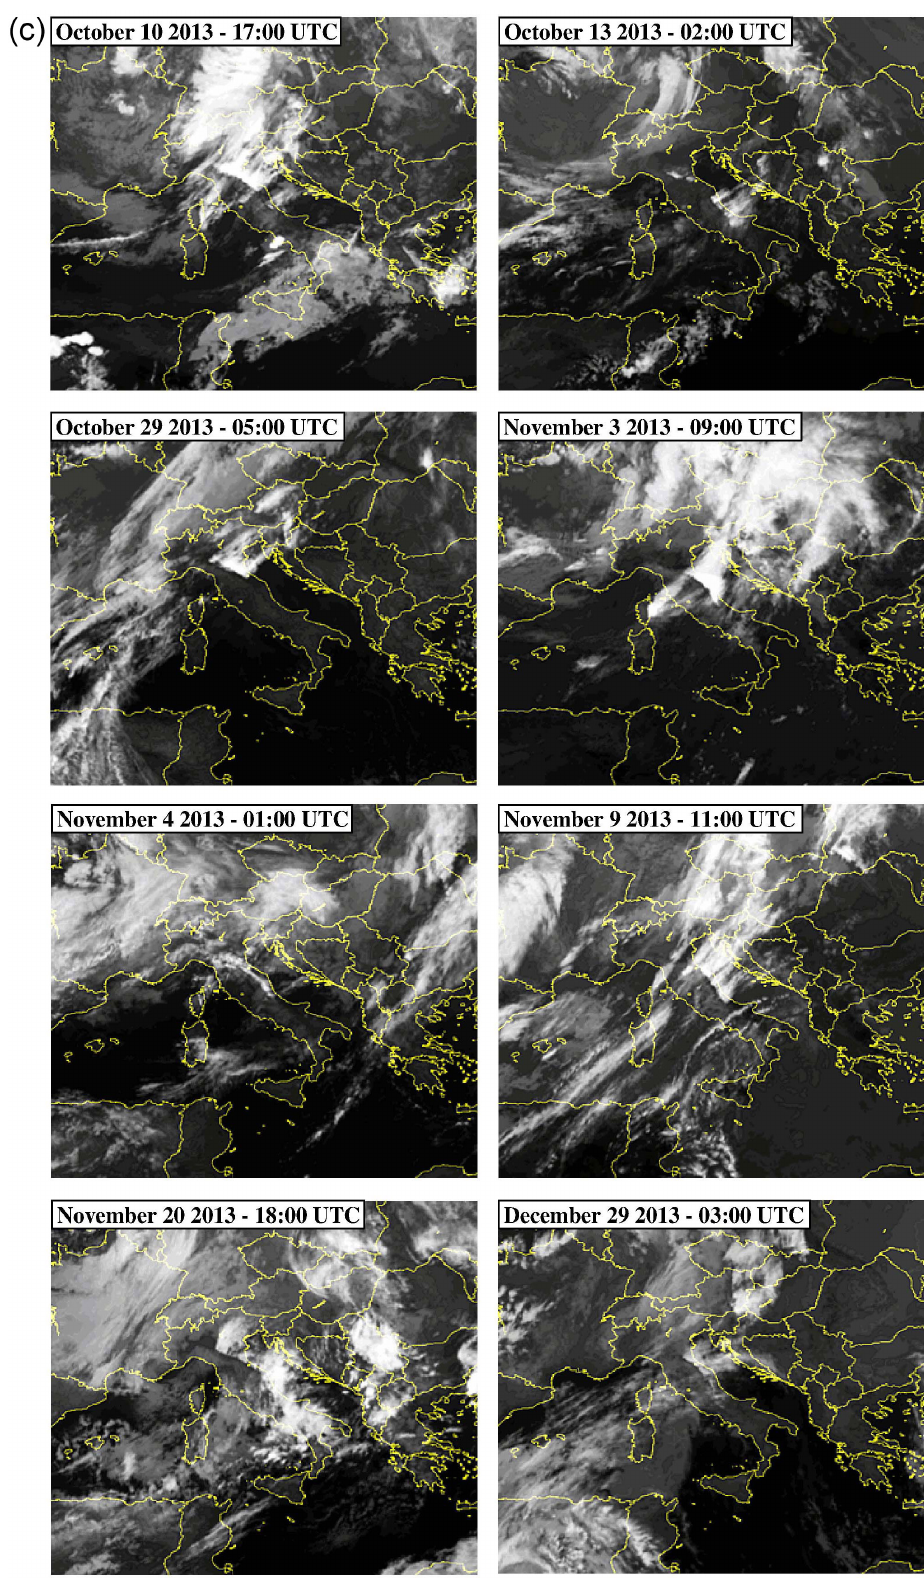
Figure 1. A total of 24 separate examples of linear-cloud formations over Italy (January 2010–December 2013), including the instance for 22 April 2012 that Guangmeng and Jie (2013) claim led them to predict the M 6 . 0 Earthquake on 20 May